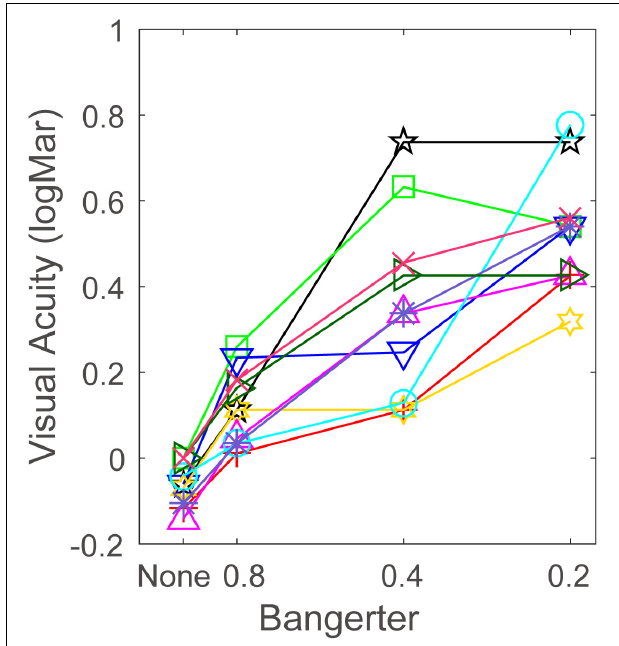
FIGURE 2 | Visual acuity (log MAR) at each Bangerter filter strength. Each symbol and color denotes one